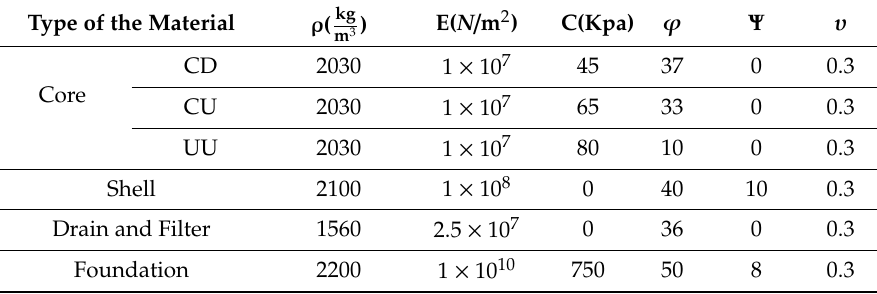
Table 2. Characteristics of dam constituent materials.